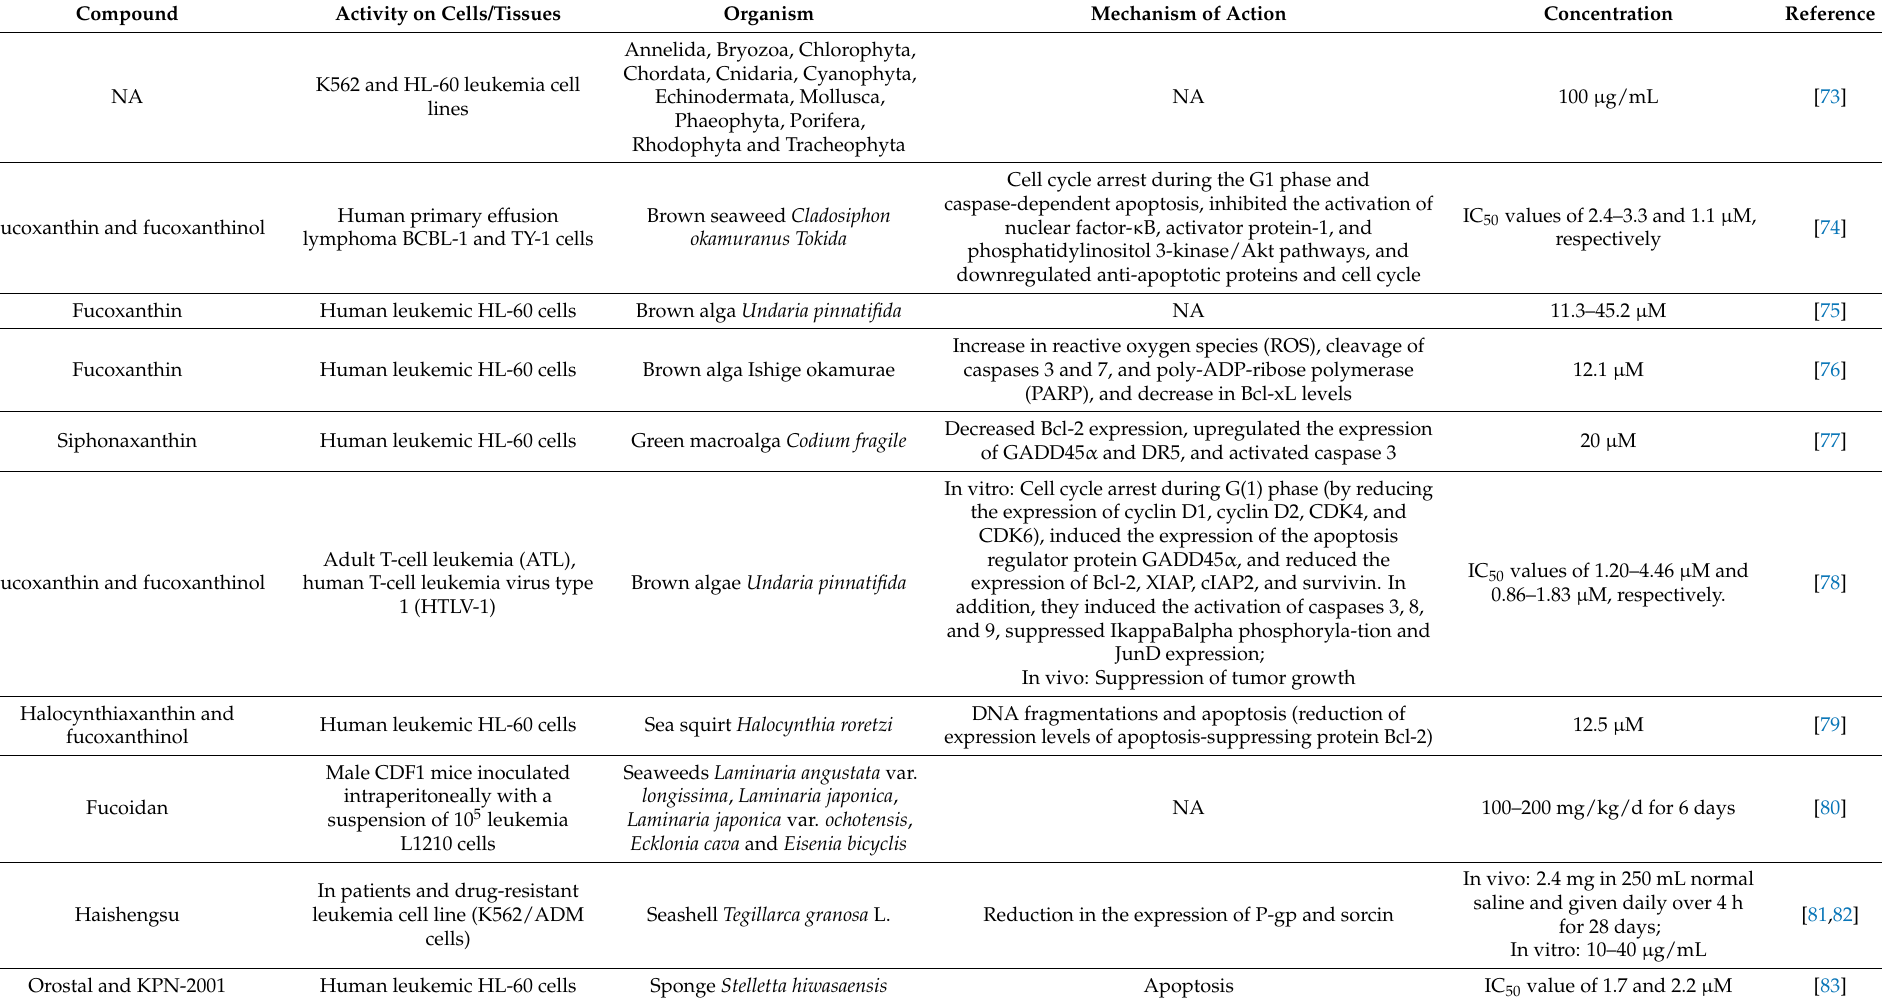
Table 4. Compounds/extracts from marine macroorganisms active for hematopoietic tumors. NA, not